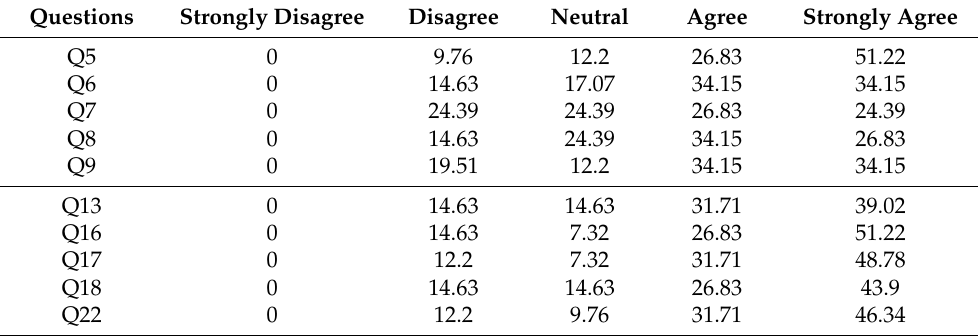
Table 3. Likert scale